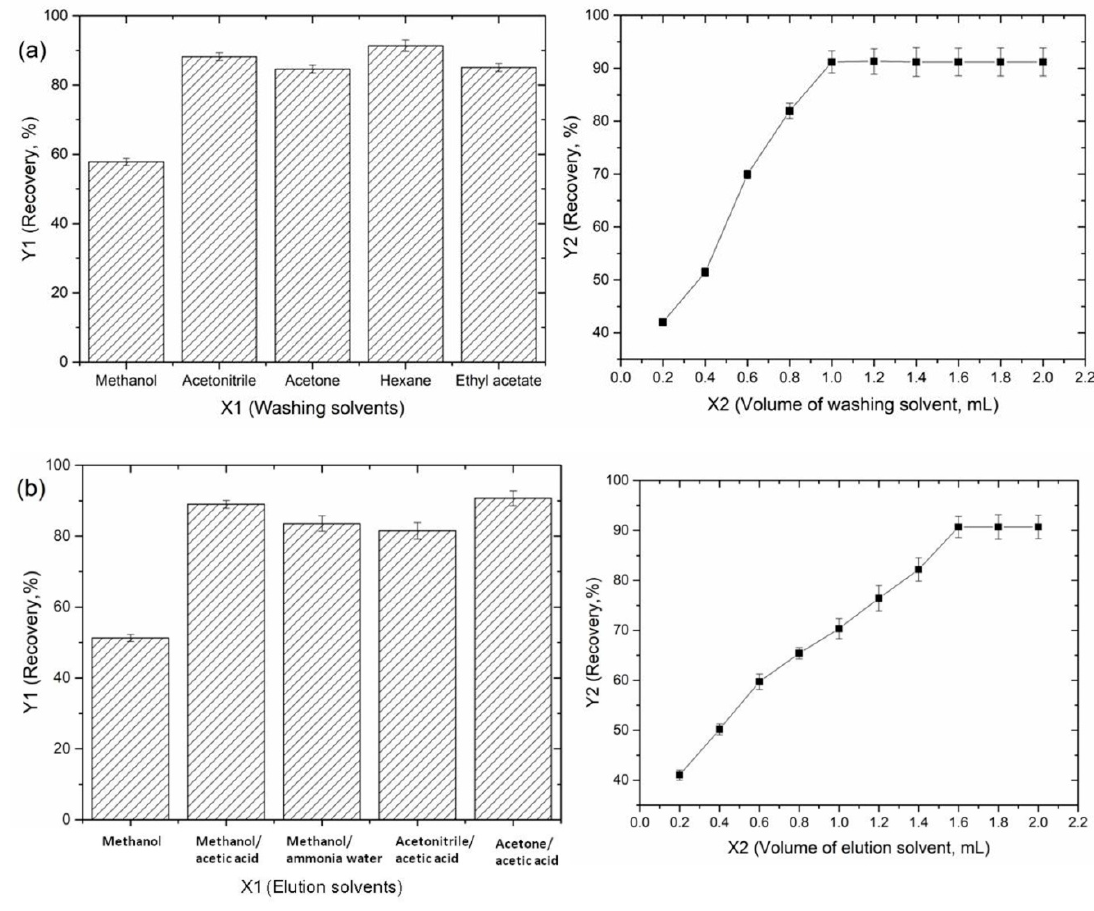
Figure 6. Optimization of the HMICS in the SPME procedure for GA (( a ): Washing solvents, ( b ): Elution solvents).